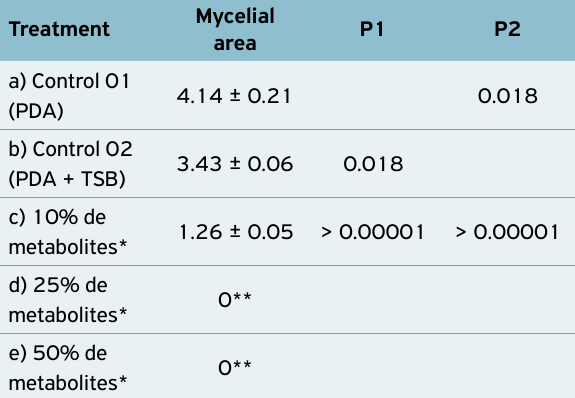
Table 1. Mycelial growth area of Leucocoprinus gongylophorus FF2006 (cm 2 ) and standard error in the five treatments used in this study.